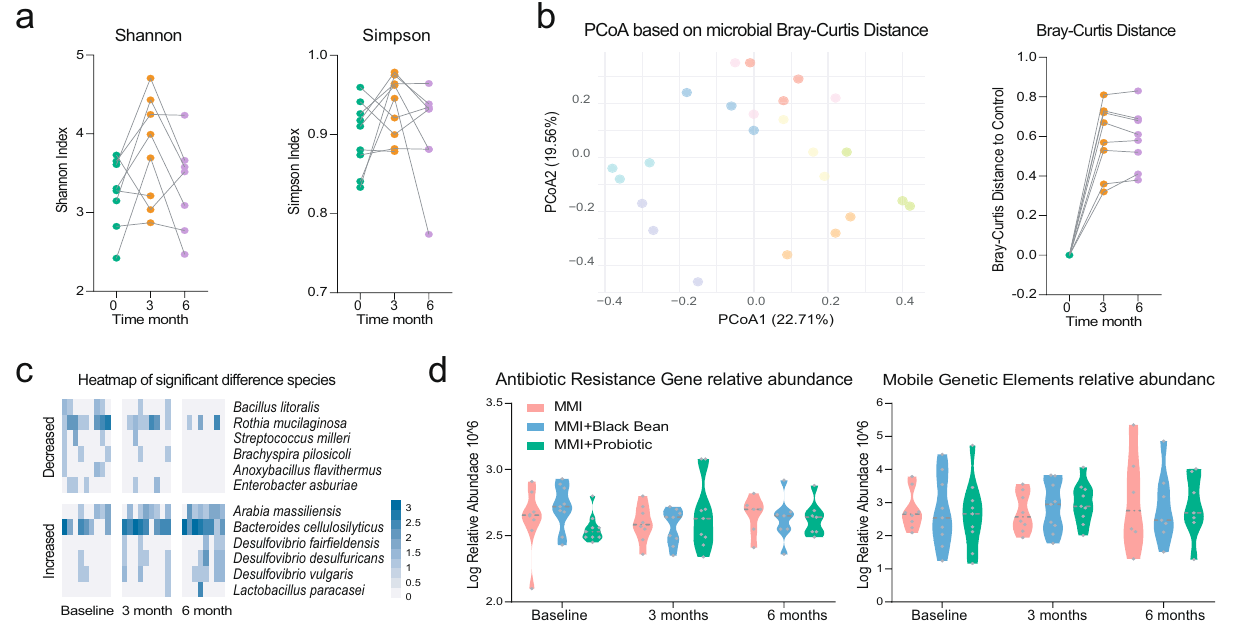
Fig. 5 The black bean adjuvant methimazole intake maintained the intestinal microbiome homeostasis of GD patients during the 6-month treatment. a The impacts of methimazole on intestinal microbial alpha diversity, the points in the same color represented the different subjects in the same time points. b Principal coordinates analysis (PCoA) based on Bray-Curtis distances of metagenomic species, the points in the same color represented the same subjects in the different time points. c The signi fi cantly different metagenomic species among different time points. d Dynamic in the relative abundance of function genes including antibiotic resistance gene and mobile genetic